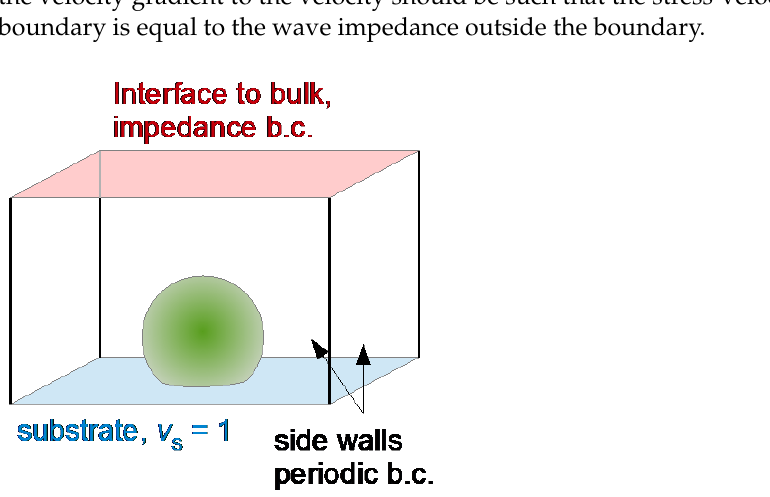
Figure 30. An example of a simulation box. An impedance boundary condition should be applied at Figure 30: An example of a simulation box. An impedance boundary condition should be 1311 applied at the top in order to let the simulation volume be small. 1312 the top in order to let the simulation volume be